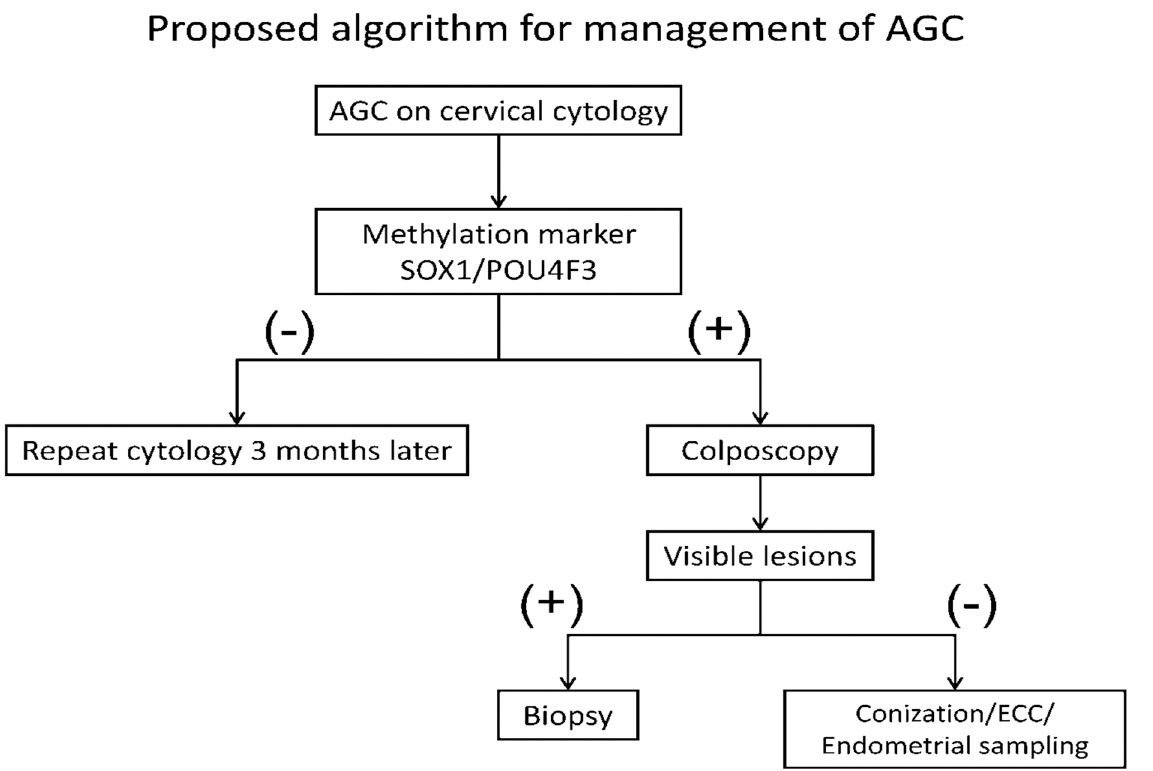
Fig 3. Proposed algorithm for management of AGC in TGOG study. For women with cytology identifying AGC, methylation biomarkers of SOX1 and POU4F3 are recommended. If, after a comprehensive examination, women with positive SOX1 m and POU4F3 m have no recognizable disease, a cervical conization or an endometrial sampling may be considered, otherwise, repeat cytology 3 months later should be the preferred recommendation because the sensitivity of SOX1 and POU4F3 is